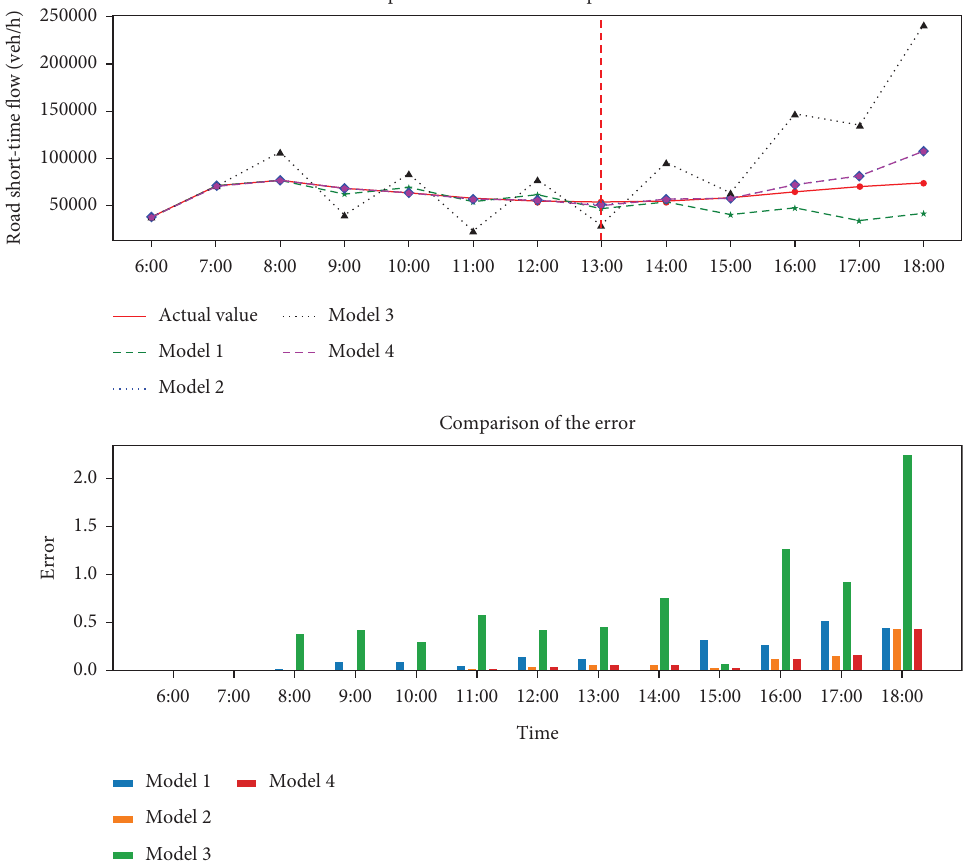
Figure 9: Schematic diagram of the predicted value of the four models on city trafc